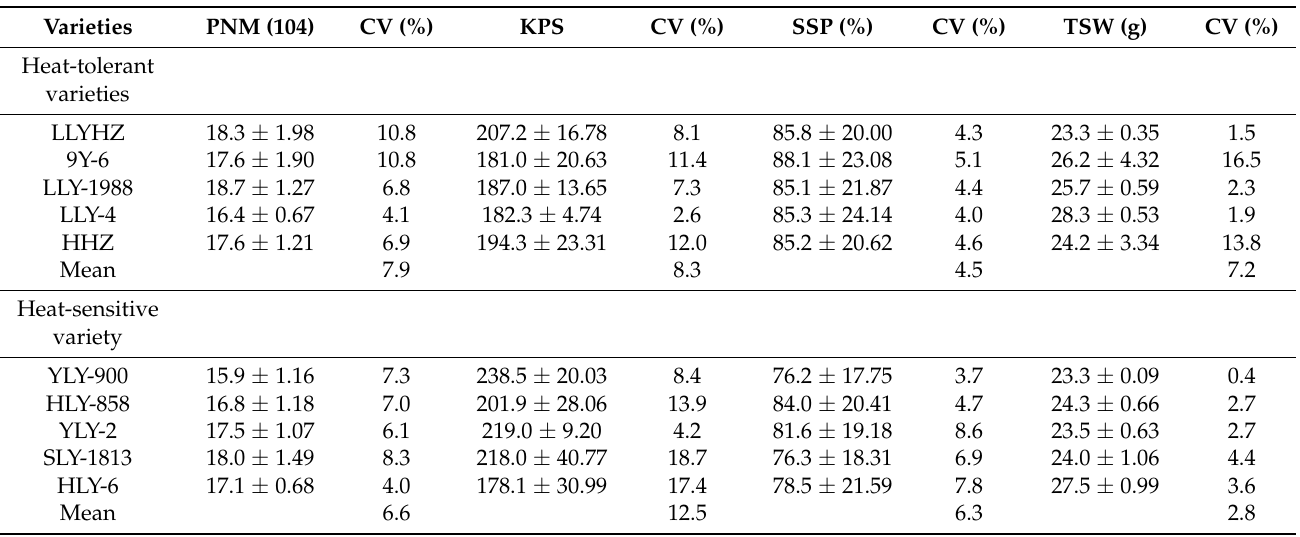
Table 5. Yield composition characteristics of heat-tolerant cultivars under different sowing